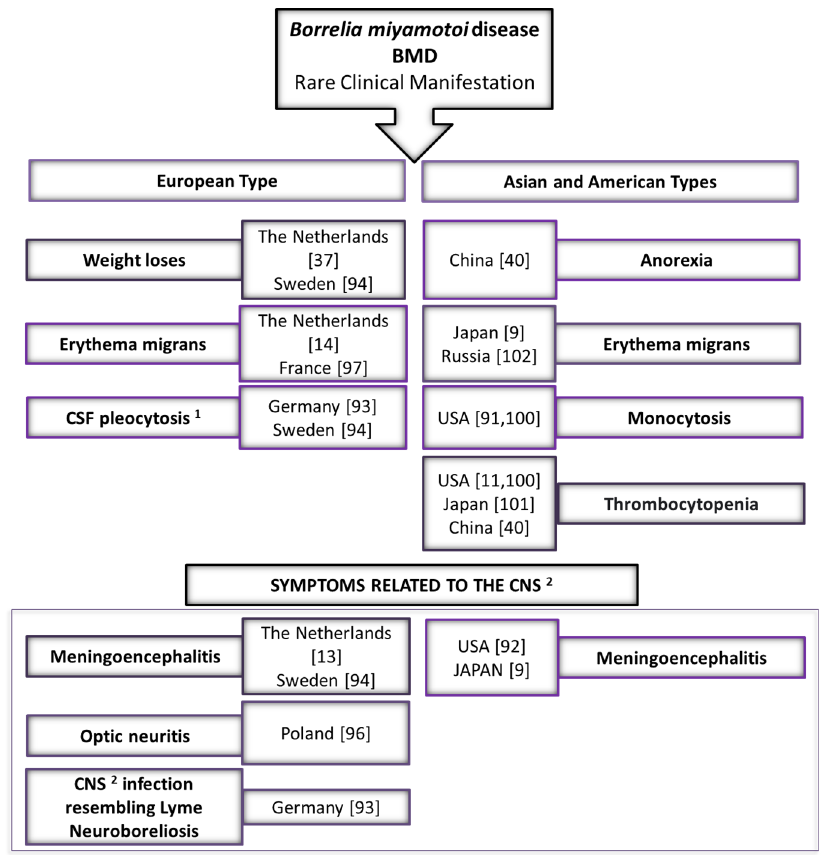
Figure 2. Rare clinical manifestations of Borrelia miyamotoi disease (BMD)—comparing the European type with Asian (Siberian) and American types. Notes: 1 CSF—cerebrospinal fluid; 2 CNS—central nervous system.